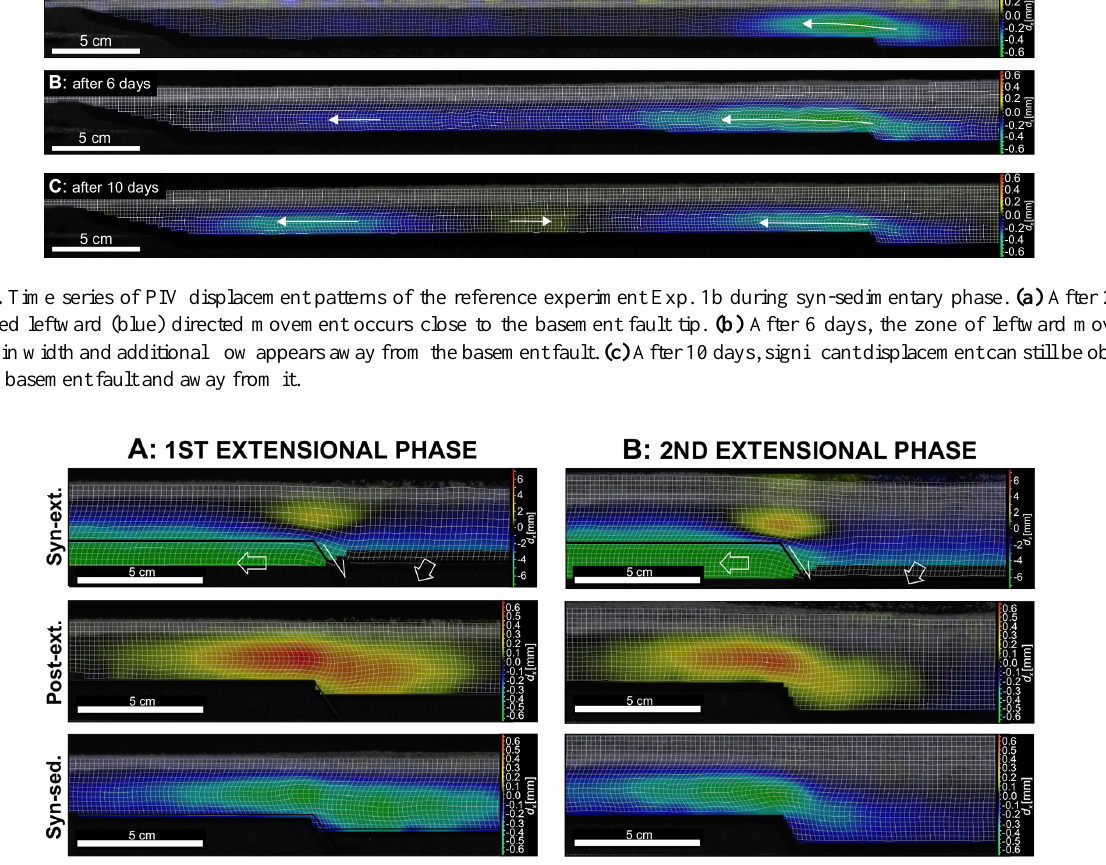
Figure 10. Comparison of horizontal displacement d x in side view above the tip of the basement fault during (a) first and (b) second phase of basement extension of the reference experiment 1b after 11 days of experimental duration. Coloured areas denote rightward (yellow–red) and leftward (green–blue) movement of the analogue